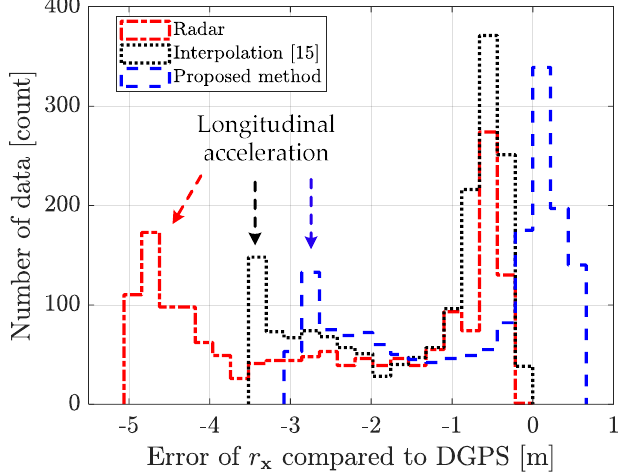
Figure 13. Histogram of the longitudinal distance error for scenario-based object estimation: using the weighted interpolation method improves the estimation performance statistically. However, there is a longitudinal error due to latency for longitudinal acceleration in the acceleration area.